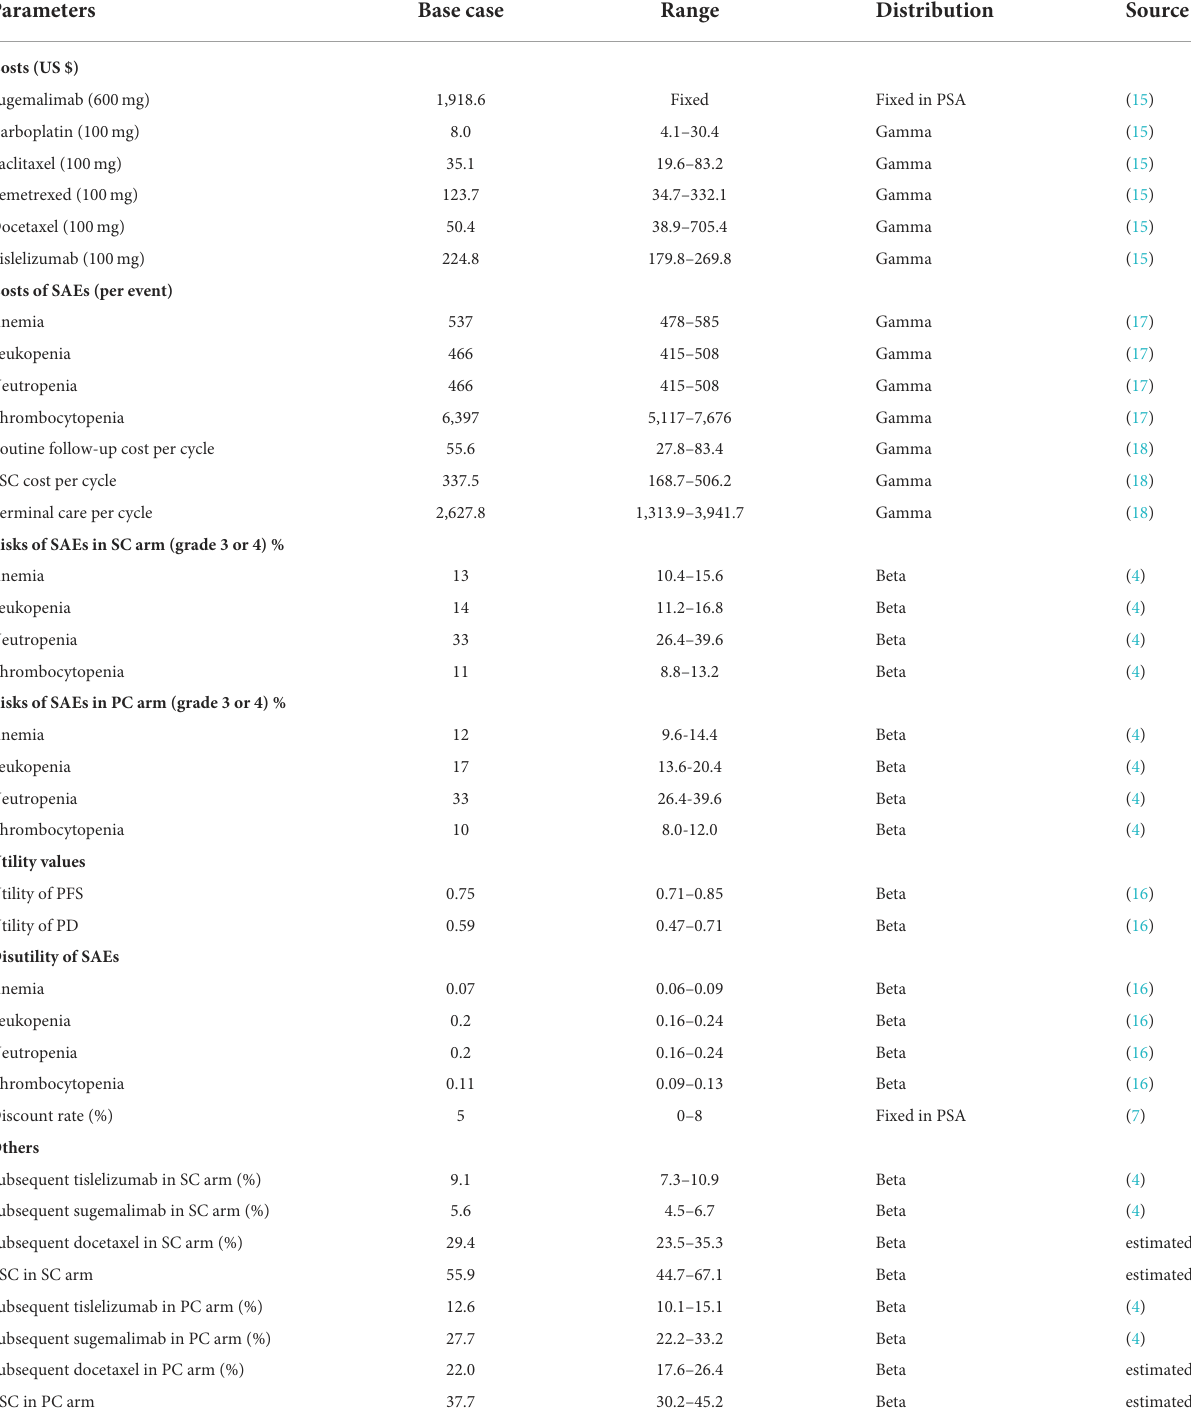
TABLE 2 Model inputs: base case values, ranges, and distributions for sensitivity analysis. Parameters Base case Range